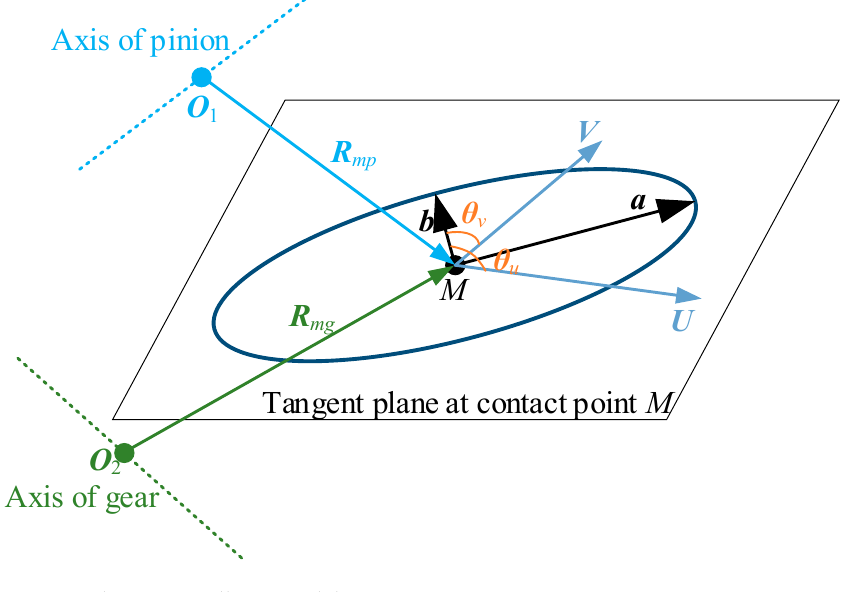
Figure 2. The contact ellipse model.